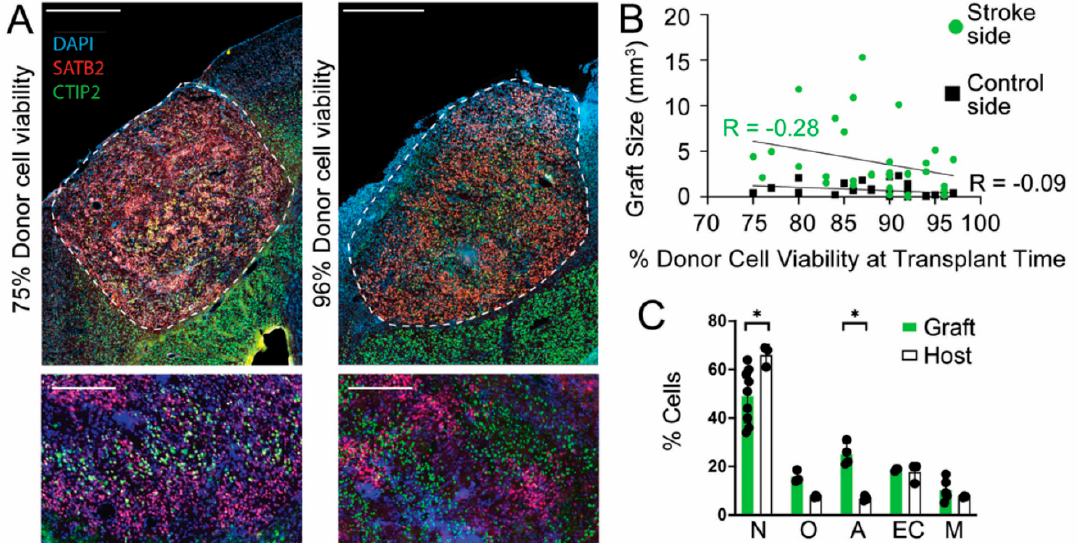
Figure 2. Size of transplants did not correlate with donor cell viability at the time of transplantation. ( A ) Sections of transplants at stroke sites with 75% (left) and 96% (right) donor cell viability at the time of transplant. Scale bars: upper panels, 500 µm; lower panels, 200 µm. ( B ) Transplant size is graphed according to the percent of viable cells immediately before transplantation into stroke (green) and contralateral control (black) sites. Each dot is a host mouse. Spearman correlation, n = 30 for each. ( C ) Cell types within grafts are compared with endogenous cells. Immunostaining was performed for SATB2 and CTIP2 (neurons), OLIG2 (oligodendrocytes), GFAP (reactive astrocytes), CD105 (endothelial cells), and IBA1 (microglia). For neurons, * p = 0.018; for reactive astrocytes, * p = 0.029. Mann–Whitney test, +/ − s.t.d.